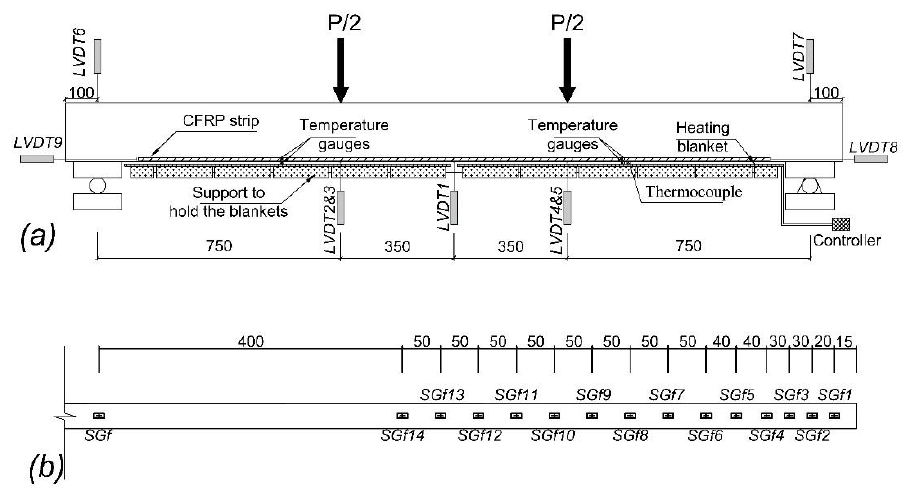
Figure 3. Test configuration: ( a ) position of linear vertical displacement transducers (LVDTs), temperature gauges, thermocouples, and heating system; ( b ) strain gauges along the carbon fiber-reinforced polymer (CFRP) laminate in specimens SB1S-1-R and SB1S-1-40 (dimensions in mm).